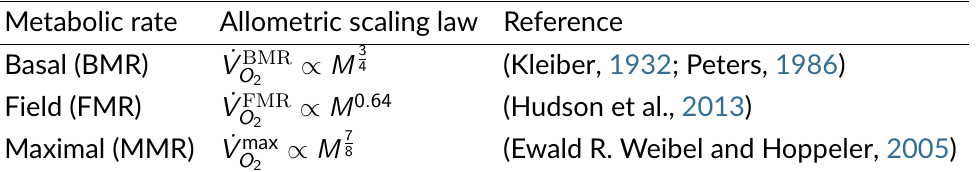
Table 2 – Allometric scaling laws for mammals of the needed oxygen flow metabolic rates. M is the mammal mass. Data from the